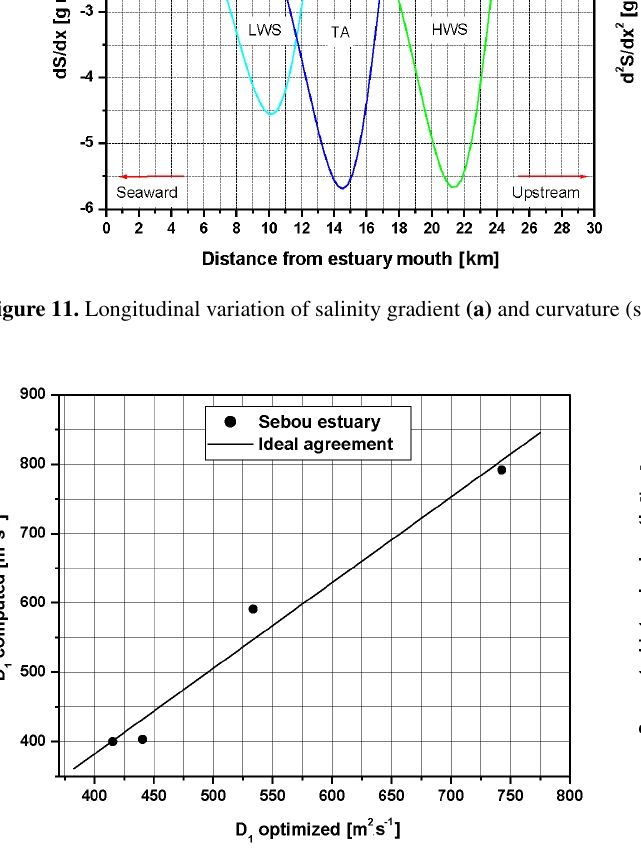
Figure 13. Salt intrusion lengths computed against observed lengths (at HWS) for different predictive formulae found in the literature (Savenije, 2005) compared with results of the actual study on Sebou